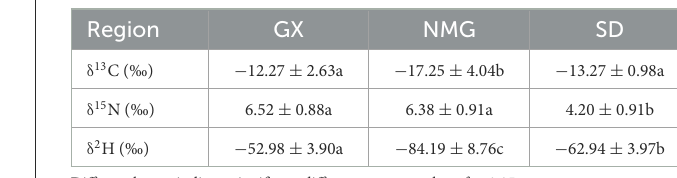
TABLE 2 A comparison of the mean δ 13 C, δ 15 N, and δ 2 H values and standard deviations of the gelatin samples from three